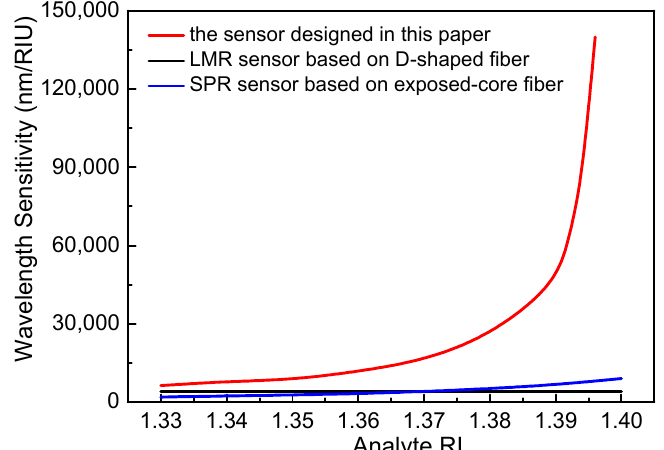
Figure 6. A wavelength sensitivity contrast of the sensor designed in this paper, common D-shaped fiber lossy mode resonance (LMR)-based sensor [24] and exposed-core PCF surface plasmon resonance (SPR)-based sensor [23].